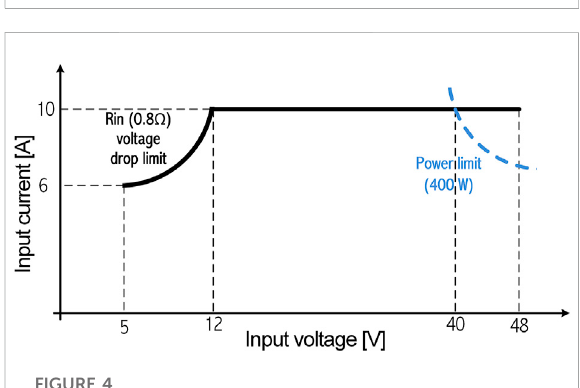
FIGURE 4 Operating V-I limits of the realized prototype.